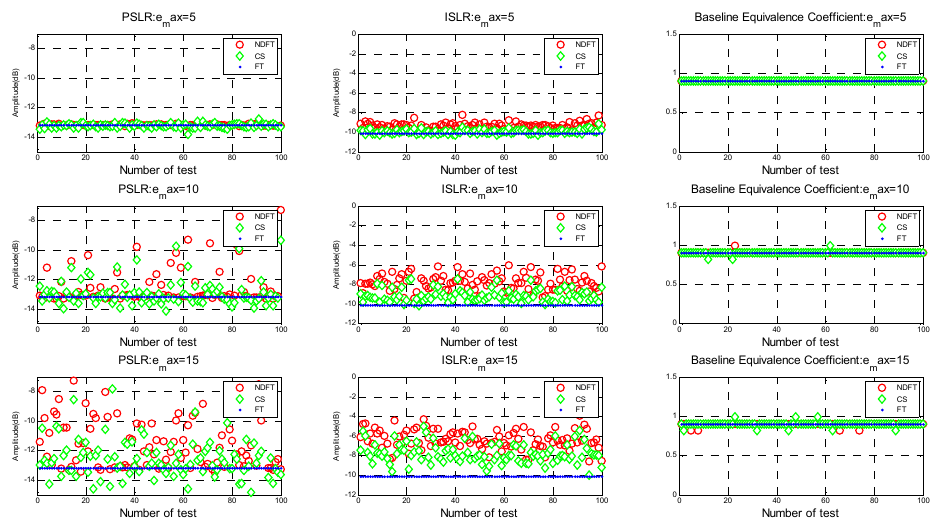
Figure 10. Imaging performance results when e max = 10%, 20%, 40%.